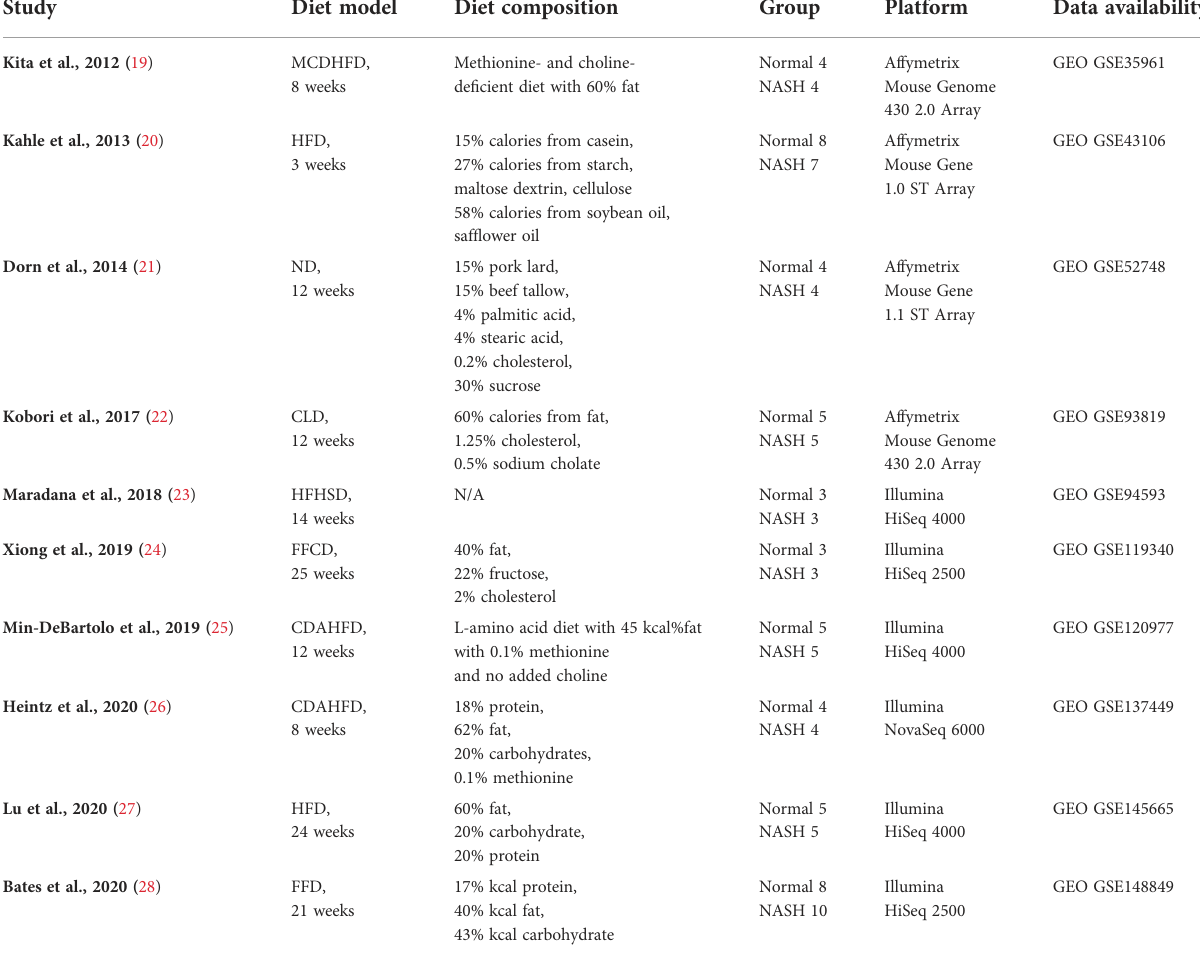
TABLE 2 Study characteristics of mouse NASH model transcriptome datasets used in this